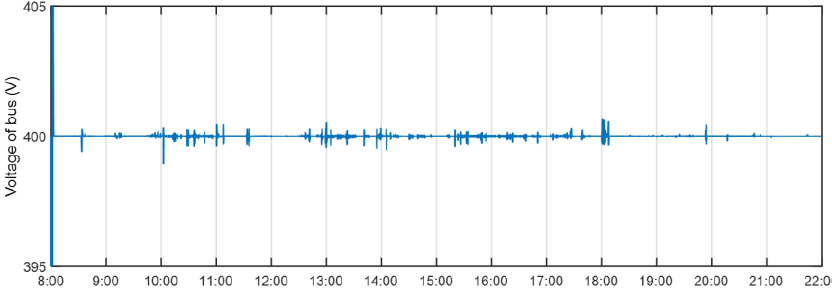
Figure 21. DC bus voltage evolution under SPVA.